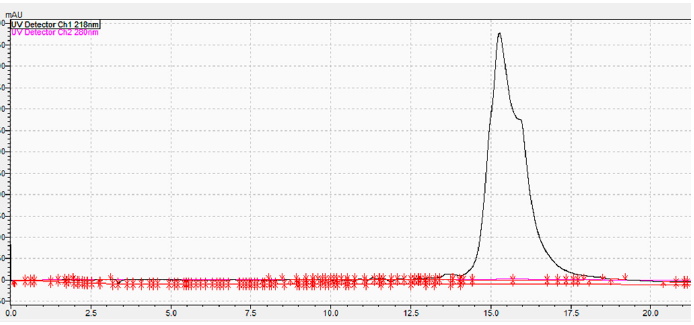
Figure 10. Reverse phase high-performance liquid chromatography (RP-HPLC) spectrum of por- cine gelatine. Figure 11. Reverse phase high-performance liquid chromatography (RP-HPLC) spectrum of bovine gelatine.